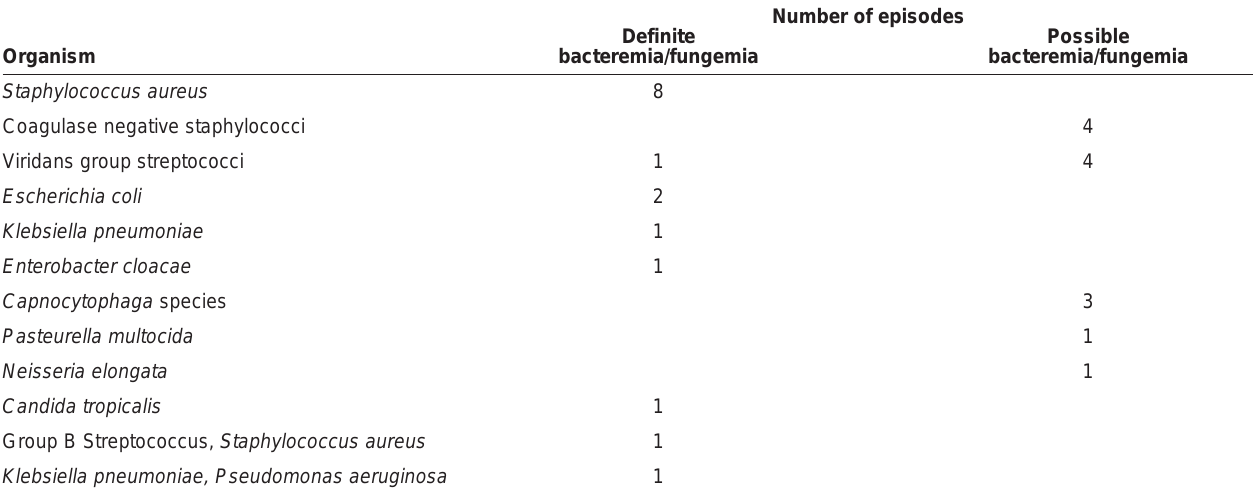
TABLE 3 Organisms grown from 29 episodes of bacteremia and/or fungemia in paediatric oncology patients within 14 days of placement of a central venous